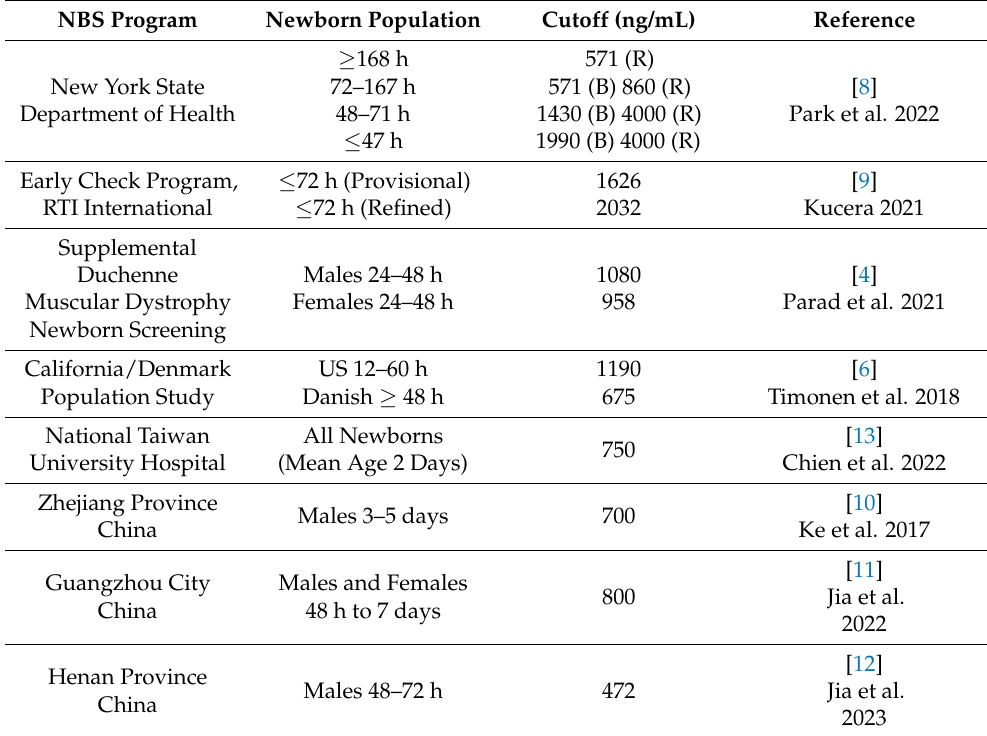
Table 3. CK-MM cut-off levels for actionable follow-up published by different NBS laboratories using the same